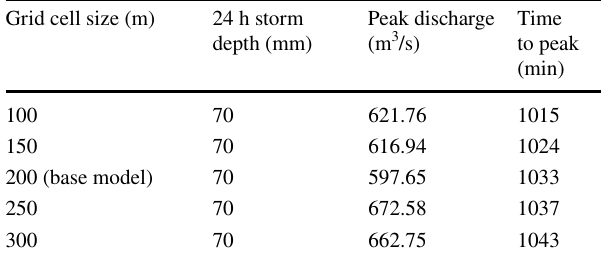
Table 10 Flood properties of calibrated GSSHA base model for a 24-h, 70 mm storm flood compared to hydrographs corresponding to GSSHA models with cell sizes of 100–300 m